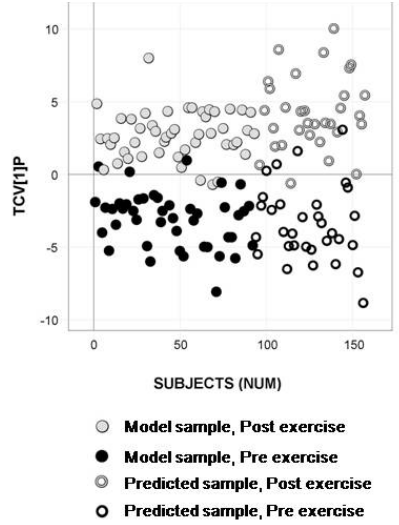
Figure 5. Longitudinal sample predictions in the classification model of subset selection 2 -analytical data. OPLS-DA predictive score plot of the model updated with the remaining samples from exercise occasion one and two showing separation between pre- exercise (black circles) and post- exercise (gray circles) serum samples (Class prediction (CV): 93.5%). Predicted test samples from exercise occasion three and four marked as open circles display high predictive classification accuracy (Class prediction (Test set): 92.2%) for pre- exercise samples (black open circles) and post- exercise samples (gray open circles).